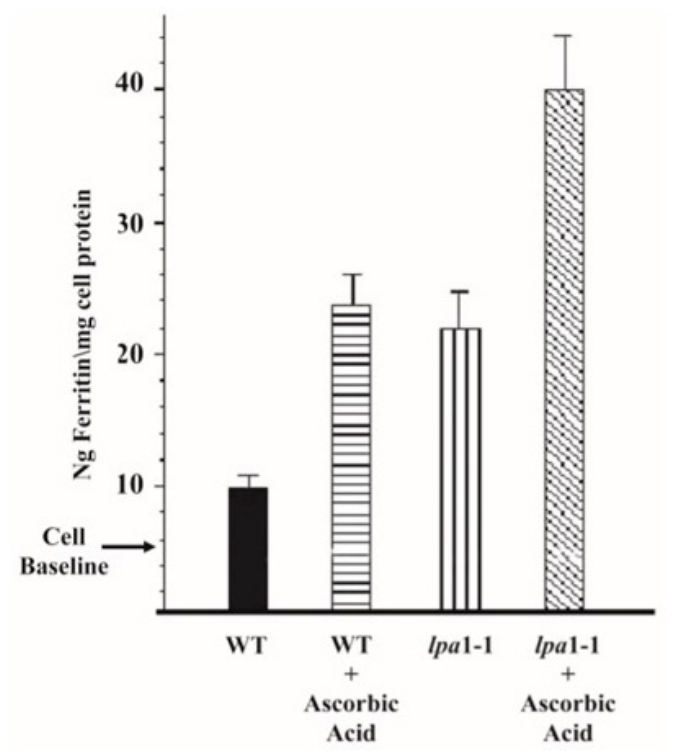
Figure 6. Caco-2 Assay for iron bioavailability from flour produced from maize wild-type (WT) and lpa 1-1 isohybrid grain. The lpa 1-1 grain contained 66% less phytic acid than WT. Bars indicated standard deviations, n = 3 (data provided by Ray Glahn, USDA-ARS Plant, Soil and Nutrition Lab, Cornell University, Ithaca, NY, USA).